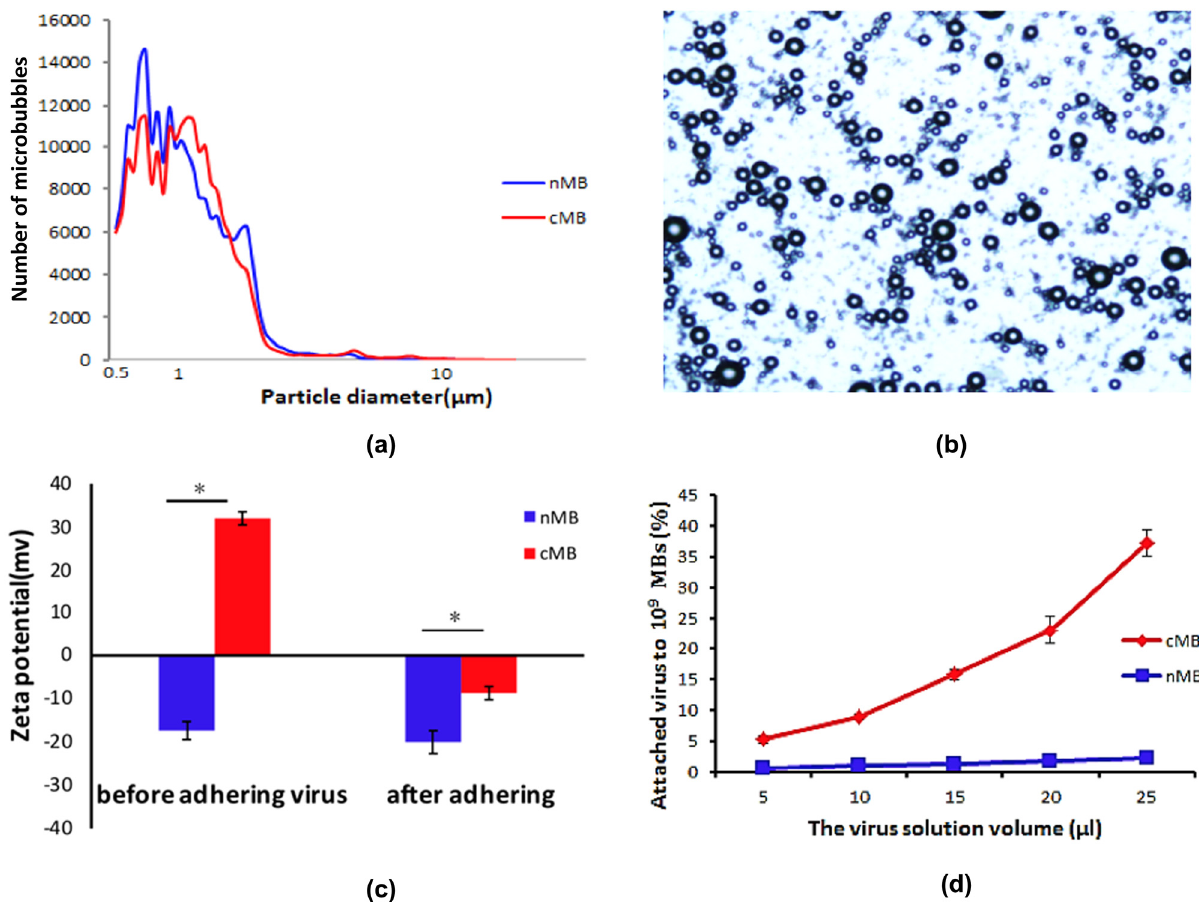
Figure 1: Characterization of virus - loaded microbubbles. ( a ) Particle size distribution of nMB ( normal microbubbles ) and cMB ( cationic microbubbles ) ; ( b ) observation of microbubbles in a light fi eld; ( c ) potential change in microbubbles after adding virus, nMB, and cMB; and ( d ) percentage of virus adhering to